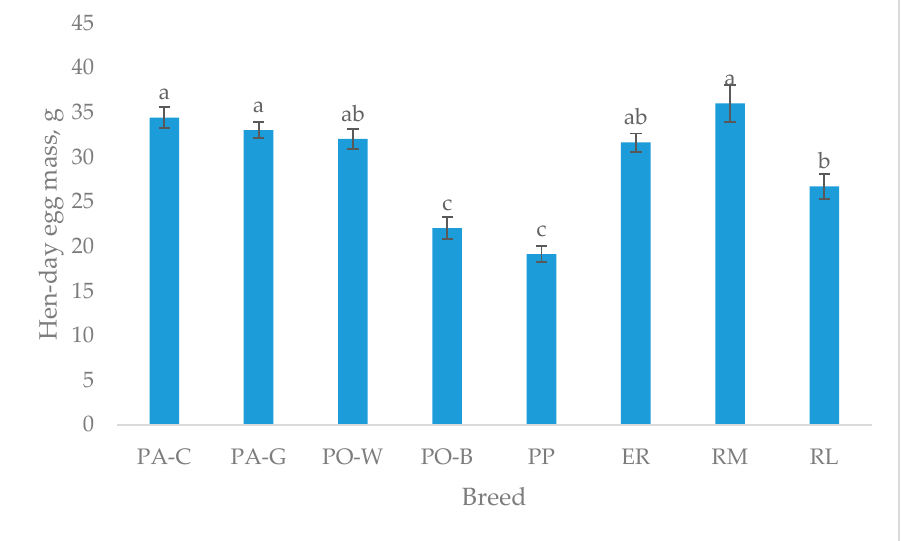
Figure 3. Least squares means (with SE) of hen ‐ day egg mass (from 49 to 50 weeks of age; observa ‐ tions ( n ) = 14 per breed). PA ‐ C: Padovana Camosciata; PA ‐ G: Padovana Dorata; PO ‐ W: Polverara Bianca; PO ‐ B: Polverara Nera; PP: Pepoi; ER: Ermellinata di Rovigo; RM: Robusta Maculata; RL: Robusta Lionata. Different letters indicate statistically different means (a,b,c: p < 0.05).